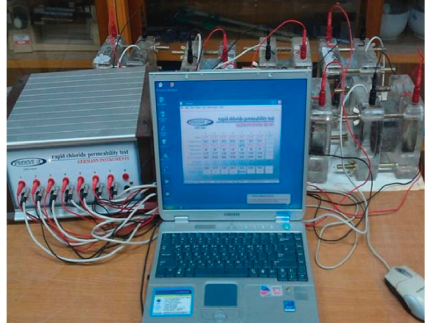
Figure 3: Chloride ion penetration test setup [16].